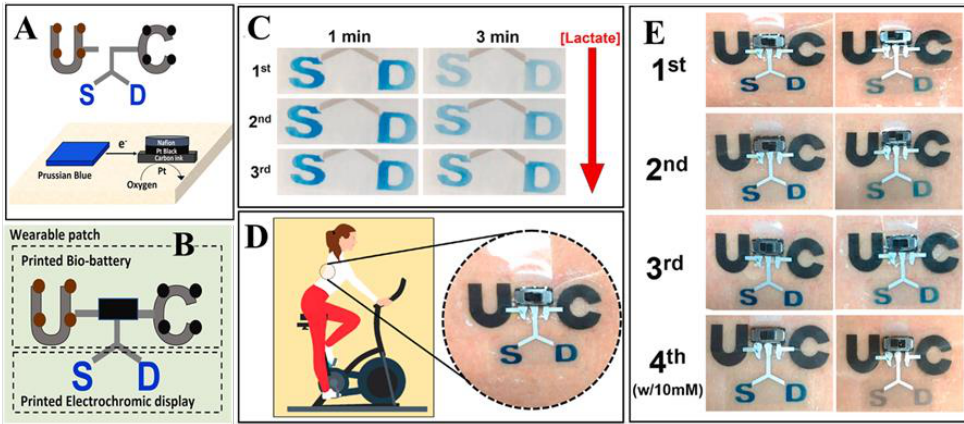
Figure 2. Sweat-powered wearable electrochromic biosensor for lactate monitoring. ( A ) Design and working principle of the wearable sweat sensor. ( B ) Different parts of the sensor i.e., printed bio- battery and electrochromic display. ( C ) Change in color of the electrochromic display after addition of human sweat samples. ( D ) Schematic of the sensor applied for on-body measurements, and ( E ) On-body images of the device with reversible behavior up to four switching cycles. Reproduced with permission from Hartel et al. © 2022 Elsevier.